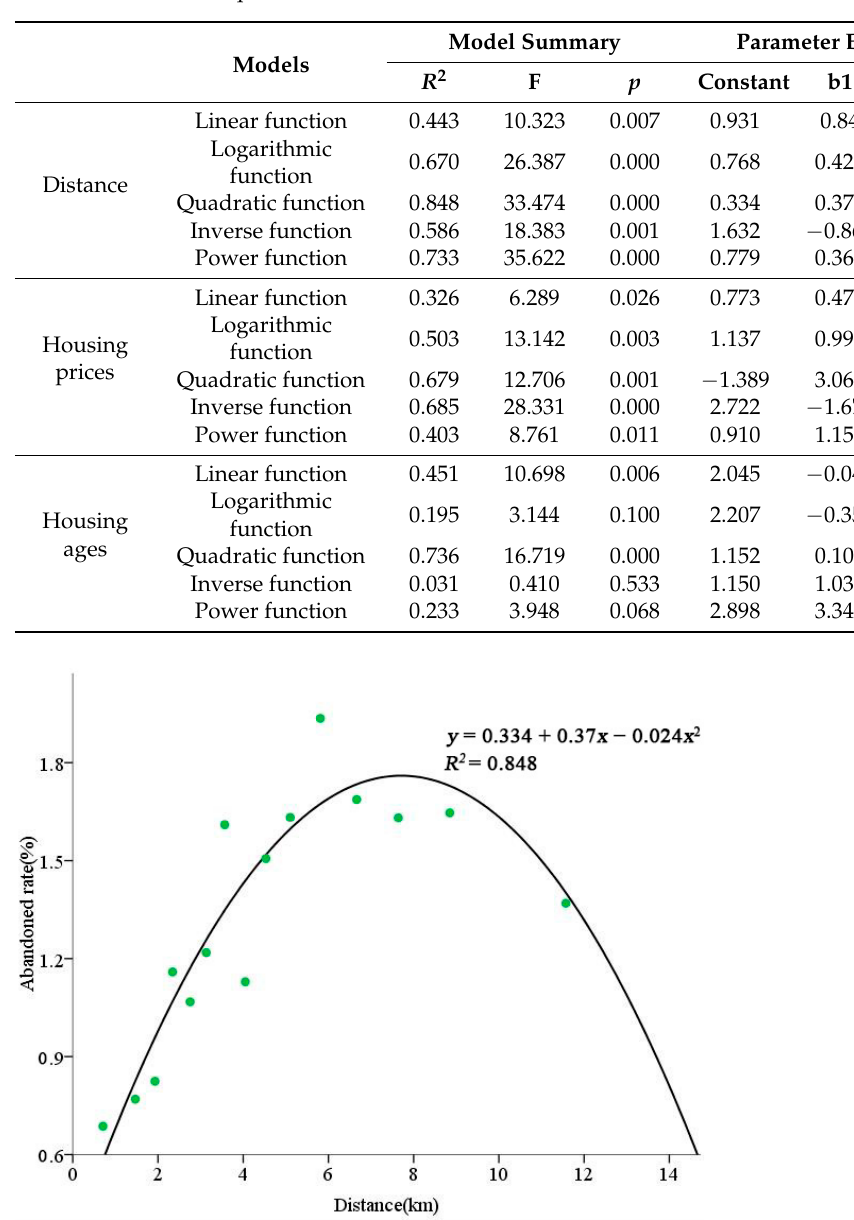
Figure 6. Fitting curve of distance and abandonment rate.